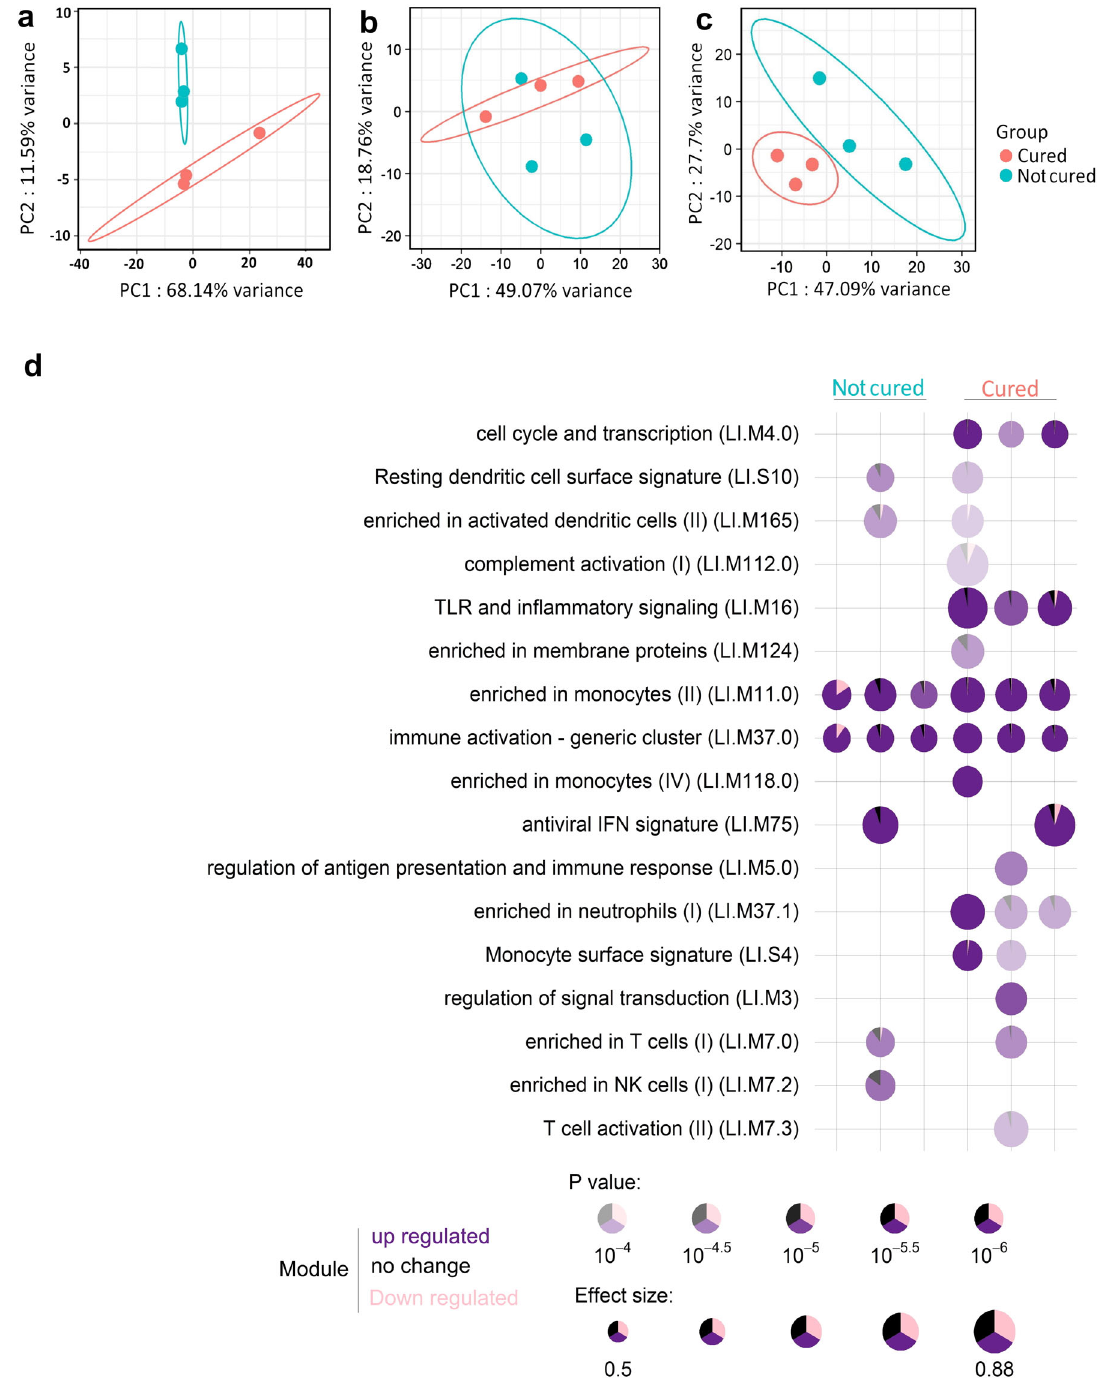
Fig. 5 Response upon the mammary booster injection and correlation with the outcome of the E. coli mammary challenge. a A principal component analysis of gene expression pro fi les (top 500 most variable genes) for the intramammary-immunized IMM cows at B7. b At 12 h post infection and c and at 40 h post infection; d a modular analysis at B7 shows the difference of upregulated biological functions between cured and not cured cows ( p value above 10 − 4 and non-infected glands. Module 2 was related to IL-17 signaling pathway and Cytokine-cytokine receptor interaction and expressed in IMM infected quarters only. Modules related to the infection were mainly correlated with IL-17 signaling and Neutrophil migration , suggesting that the local Th17 response promoted mobilization of neutrophils, which was protective against E. coli infection.